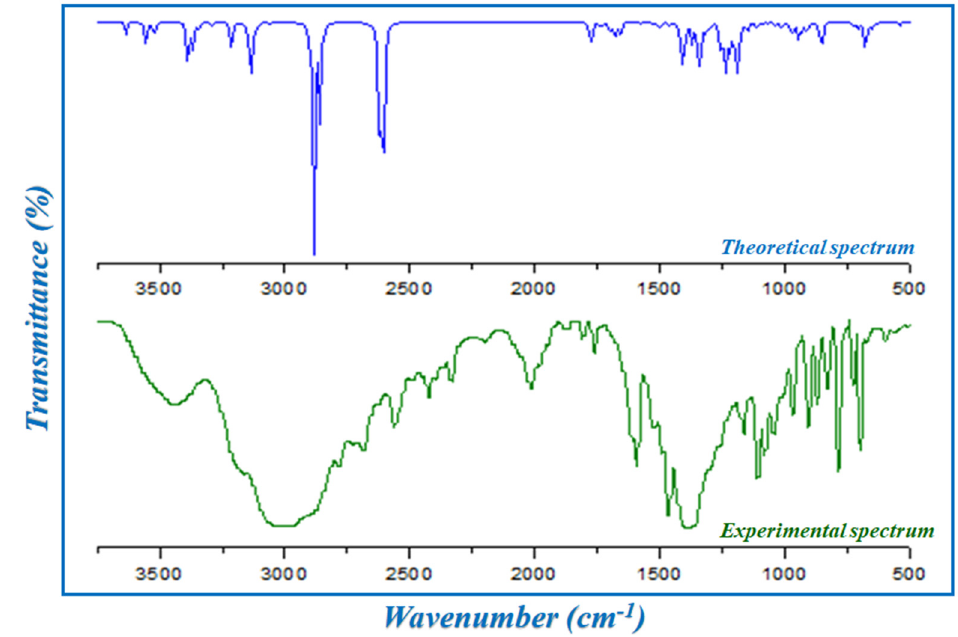
Figure 5. The experimental and theoretical infrared spectra of HTN.